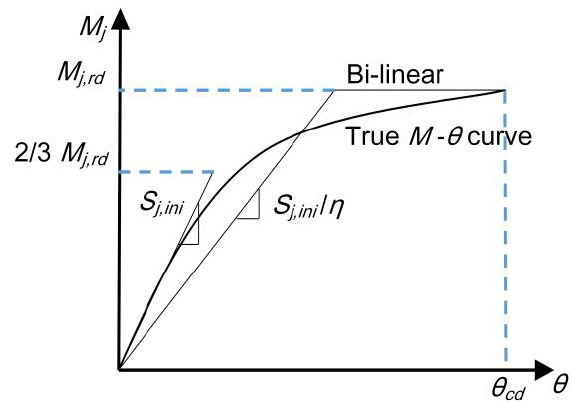
Figure 15. Moment-rotation curve of the semi-rigid joint in EN1993-1-8:2005 [12].